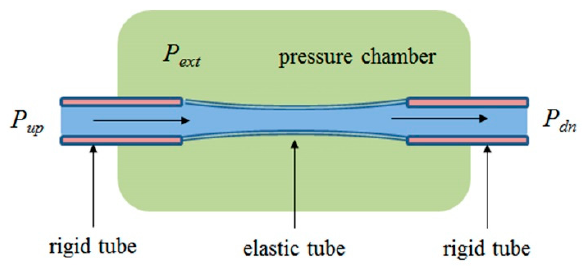
Figure 2. The experimental set-up known as a Starling resistor. An elastic tube clamped between rigid tubes is surrounded by an outer pressure chamber. Flow is driven through the tube from left to right by an applied pressure differences, P up - P dn . The pressure of the chamber, P ext , can be adjusted to control the average diameter of the elastic tube. P up : upstream pressure; P dn : downstream pressure; P ext : external chamber pressure.